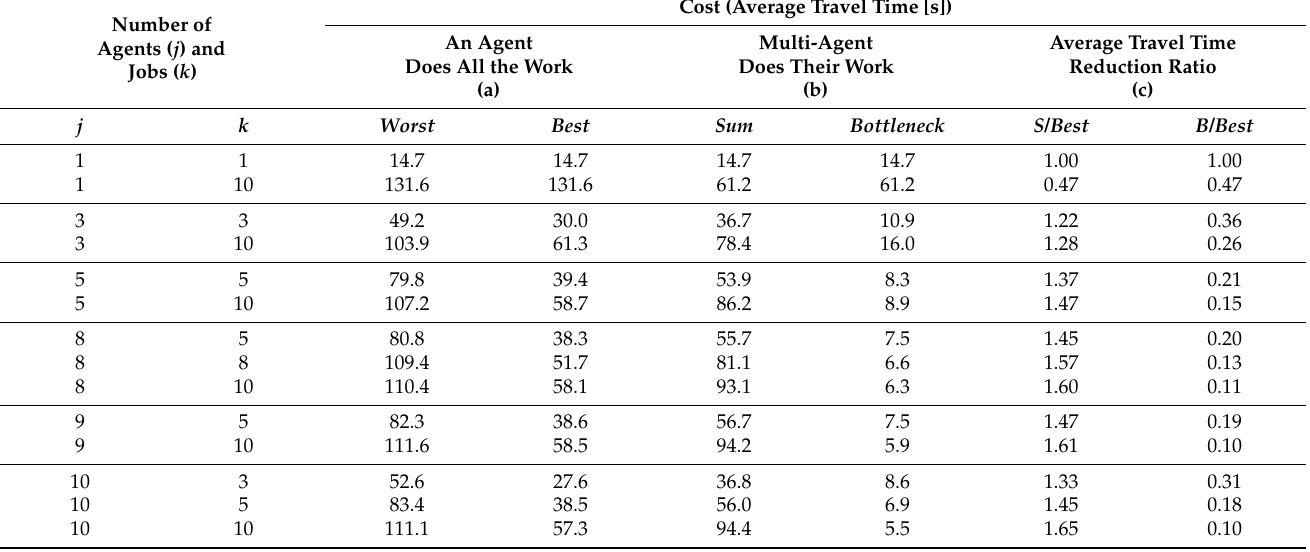
Table 3. Ground cost value of the test dataset.